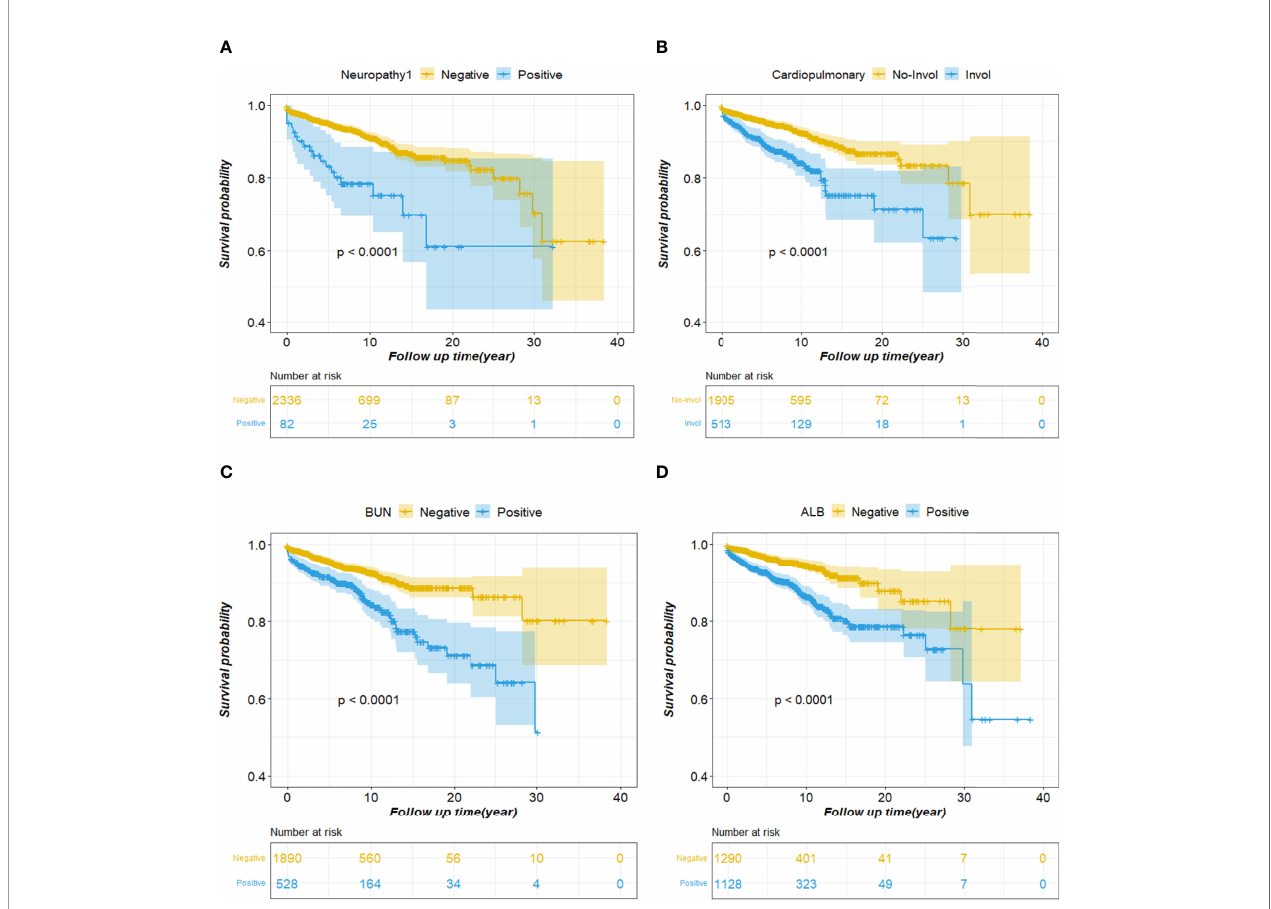
FIGURE 2 | Cumulative survival curves of the survival factor. (A) Neuropathy; (B) Cardiopulmonary; (C) BUN; (D) ALB. BUN, blood urea nitrogen; ALB,